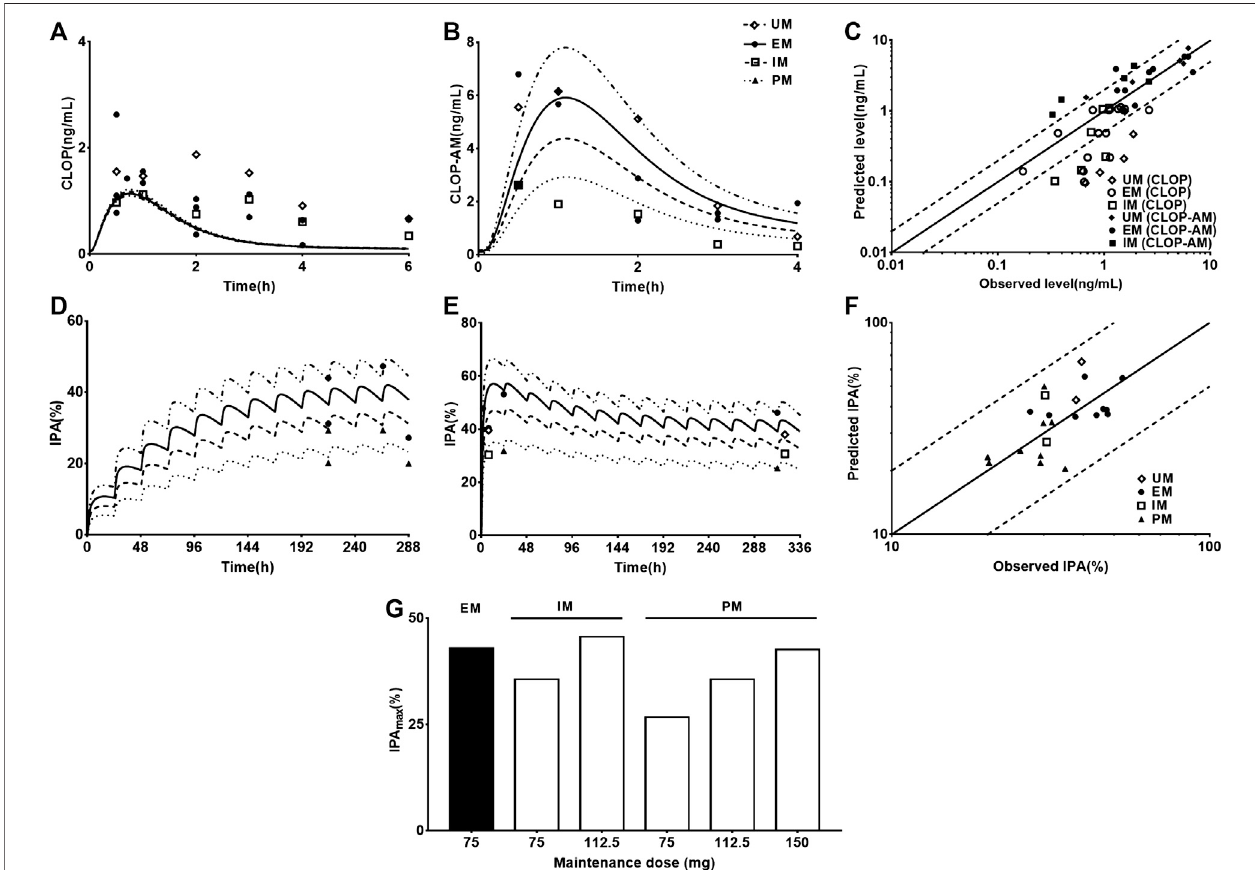
FIGURE4| Thepredicted(line)andobserved(point)plasmaconcentration-timepro fi lesandIPA-timepro fi lesfollowingoraldosetoCADpatientscarryingdifferent CYP2C19 phenotypes. (A) CLOP after 75 mg maintenance dose daily, and the observed data were from Danielak (UM n (cid:1) 25, EM n (cid:1) 18, IM n (cid:1) 20) (Danielak et al., 2017), Fallah (EM n (cid:1) 5) (Fallah et al., 2016) and Karazniewicz-Lada (UM n (cid:1) 18, EM n (cid:1) 16, IM n (cid:1) 10) (Karazniewicz-Lada et al., 2014); (B) CLOP-AM after 75 mg maintenancedosedaily,andtheobserveddatawerefromDanielak(UM n (cid:1) 25,EM n (cid:1) 18,IM n (cid:1) 20)(Danielaketal.,2017)andKarazniewicz-Lada(UM n (cid:1) 18,EM n (cid:1) 16, IM n (cid:1) 10) (Karazniewicz-Lada et al., 2014). (C) shows the relationship between the observed and predicted plasma concentration of CLOP and CLOP-AM in differentmetabolizers.Solidanddashed lines respectively represent unityand 2-fold errors betweenobservedand predicted data. (D) IPA(%)after 75 mgmaintenance dosedailywithoutloadingdose,theobserveddatawerefromErlinge(EM n (cid:1) 49,PM n (cid:1) 14)(Erlingeetal.,2014),Gurbel(2013,EM n (cid:1) 36,PM n (cid:1) 10forsmokers;EM n (cid:1) 45, PM n (cid:1) 9 for nonsmokers) (Gurbel et al., 2013) and Gurbel (2014, EM n (cid:1) 153, PM n (cid:1) 38) (Gurbel et al., 2014). (E) IPA (%) after 600 mg loading dose followed by 75 mg maintenance, whose observations from CHDTantry (UM n (cid:1) 28, EM n (cid:1) 31, IM n (cid:1) 20, PM n (cid:1) 3) (CHDTantry et al., 2010) and Varenhorst (EM n (cid:1) 37, PM n (cid:1) 9) (Varenhorst et al., 2009). (F) The relationship between the observed and predicted IPA (%) values in CAD patients. (G) The simulated dose- and CYP2C19 phenotype- dependent IPA following 300 mg loading dose followed by maintenance